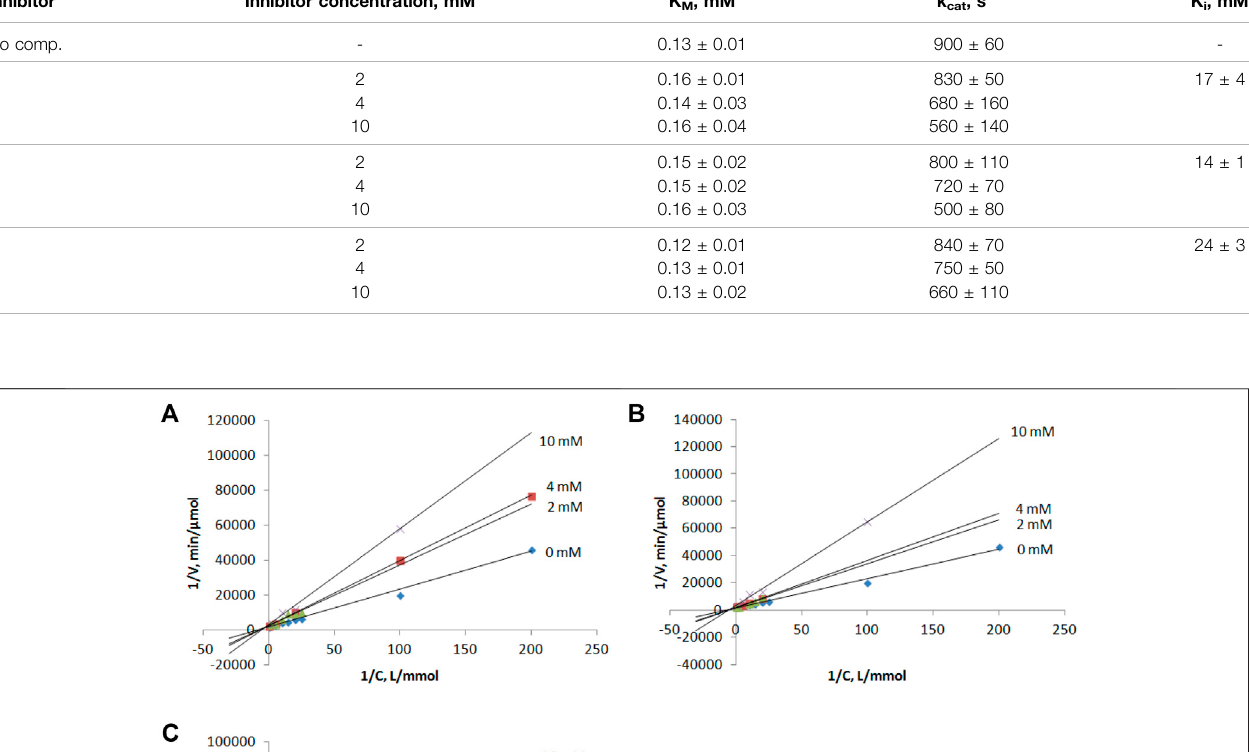
TABLE 1 | Kinetic parameters of inosine phosphorolysis inhibition. Inhibitor Inhibitor concentration, mM No comp.